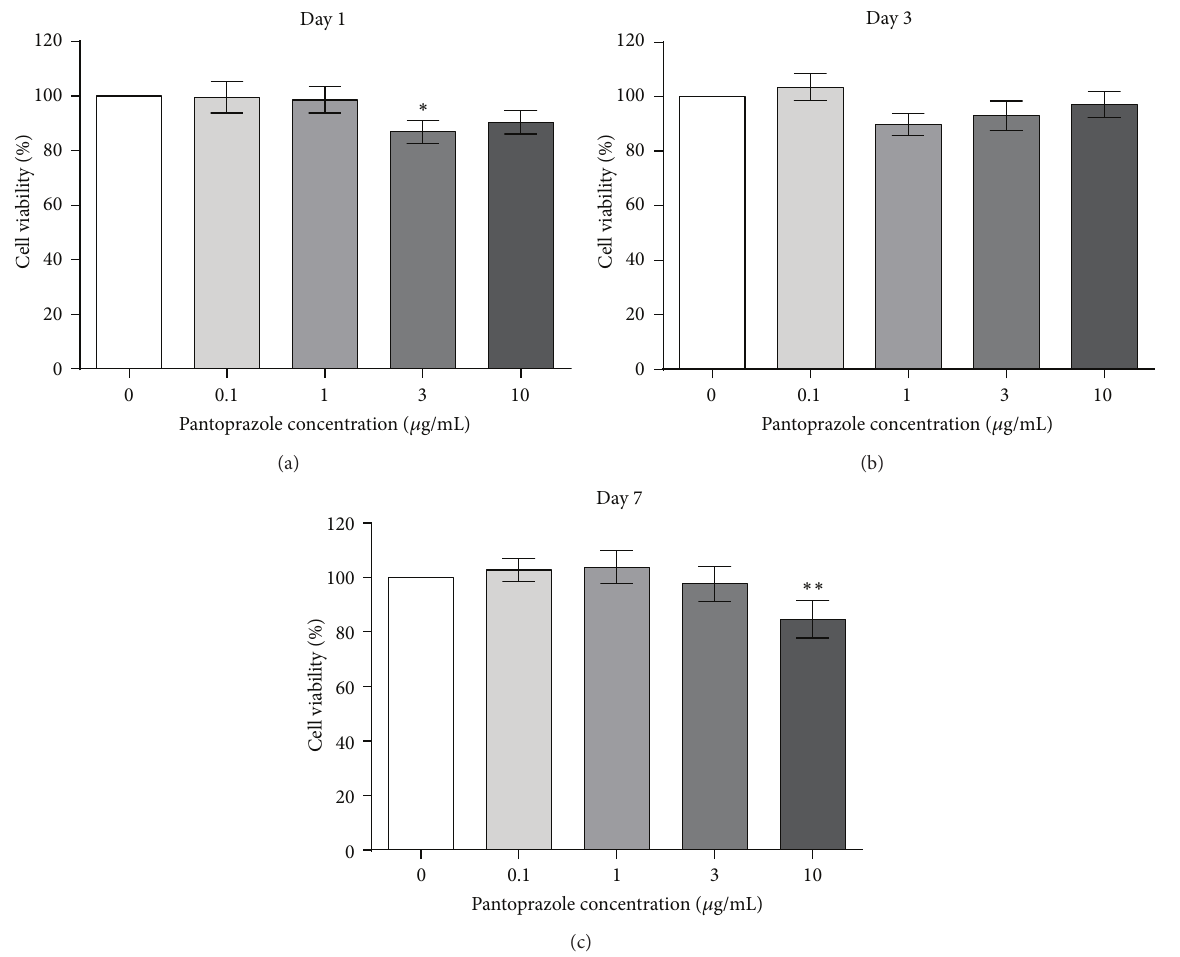
Figure 5: The MTT cell viability assays performed on days 1, 3, and 7 of stimulation with pantoprazole ( 𝑁 = 4 , 𝑛 = 6 ). The viability in relation to the respective negative control was assessed. The results were expressed as percentages of the negative control values. Shown are column bar graphs of means ± SEM. ∗ 𝑃 < 0.05 and ∗∗ 𝑃 < 0.01 versus the untreated